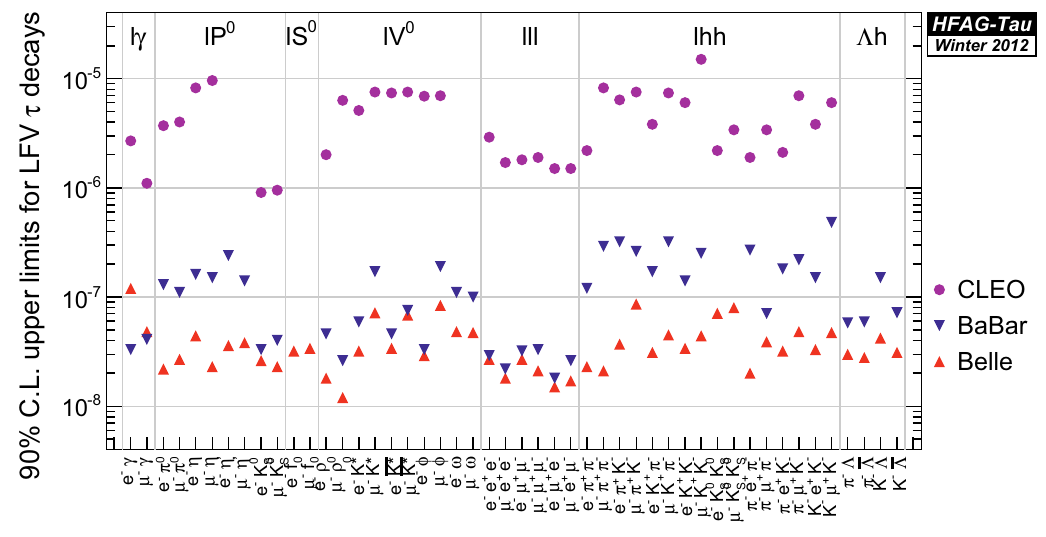
Figure 1. A summary of the LFV from BELLE and B A B AR as presented in the HFAG 2012